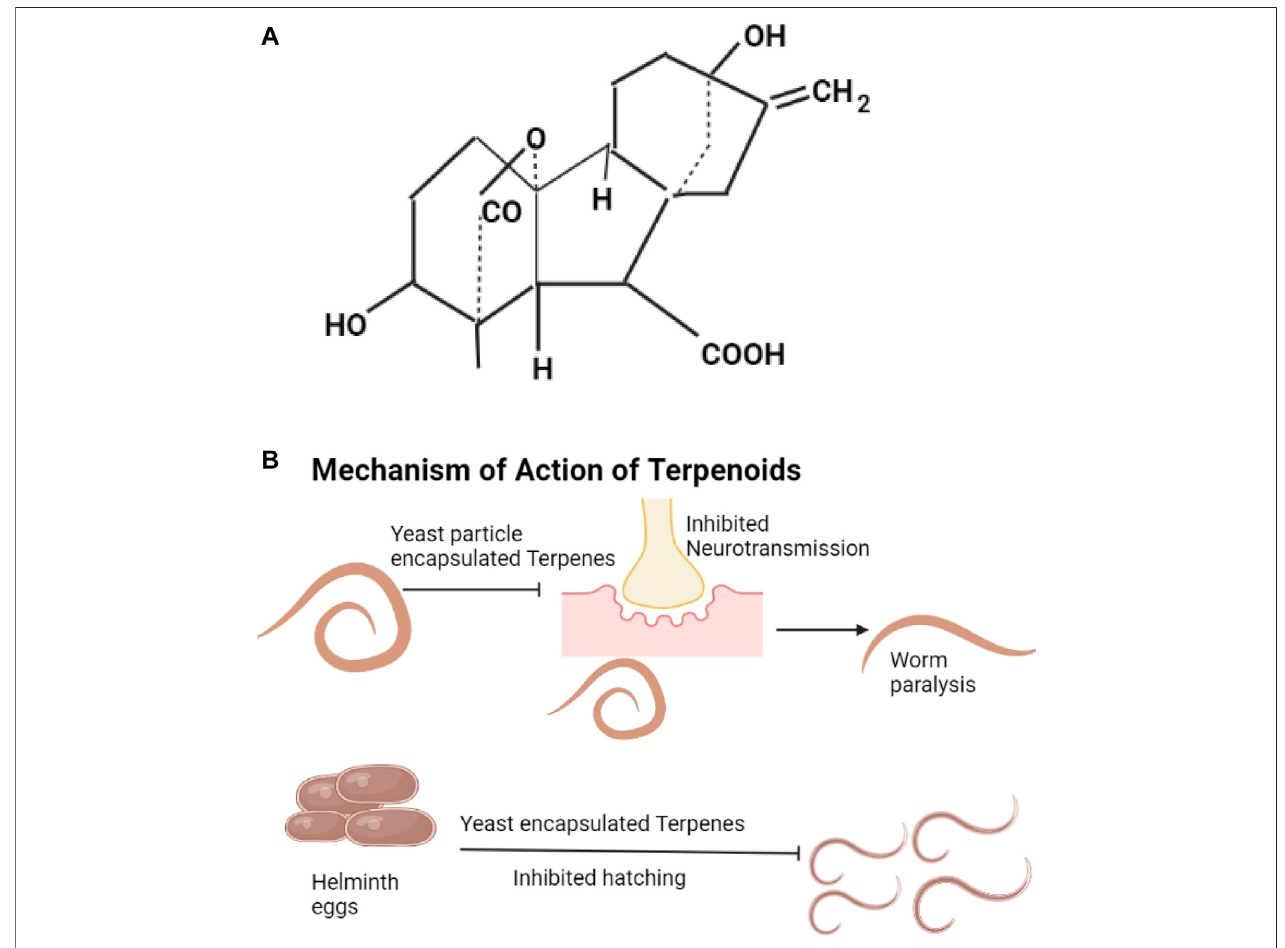
FIGURE 4 | (A) The structure of gibberellic acid (Sponsel, 2003). (B) Yeast encapsulated terpenes inhibit neurotransmission and lead to helminth paralysis, they also inhibit hatching of helminths